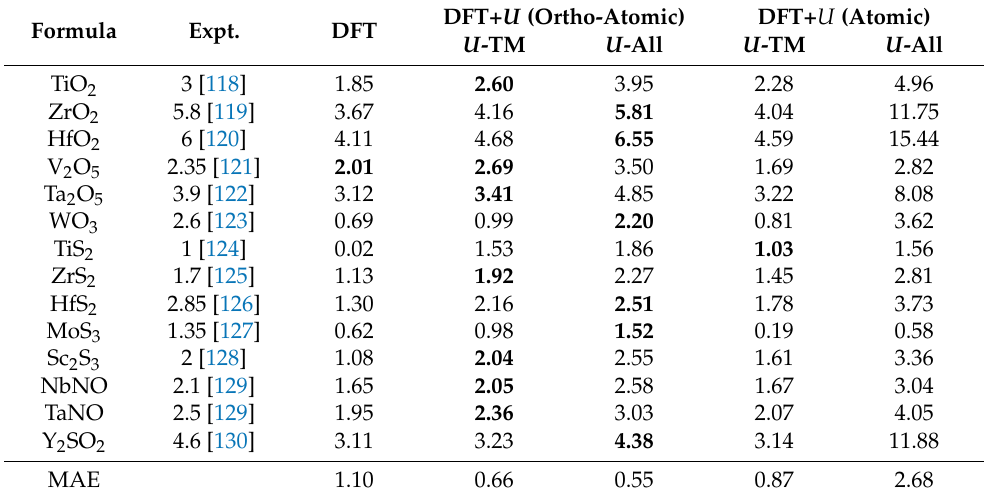
Table 3. Comparison of the band gaps (in eV) as computed using DFT and DFT+ U (using ortho-atomic and atomic projectors) and as measured in experiments for compounds containing TM elements, with the mean absolute error (MAE) given for each method. DFT+ U results obtained with ortho-atomic and atomic projectors are split into two columns each: (1) band gaps predicted with U corrections applied only to the d states of TM elements ( U -TM), and (2) band gaps predicted with U corrections applied to the d states of TM and p states of light elements ( U -All). The computationally predicted band gaps with the closest values to the experimental band gaps are highlighted in bold. DFT+ U (Ortho-Atomic) DFT+ U (Atomic) Formula Expt. DFT U -TM U -All U -TM TiO 2